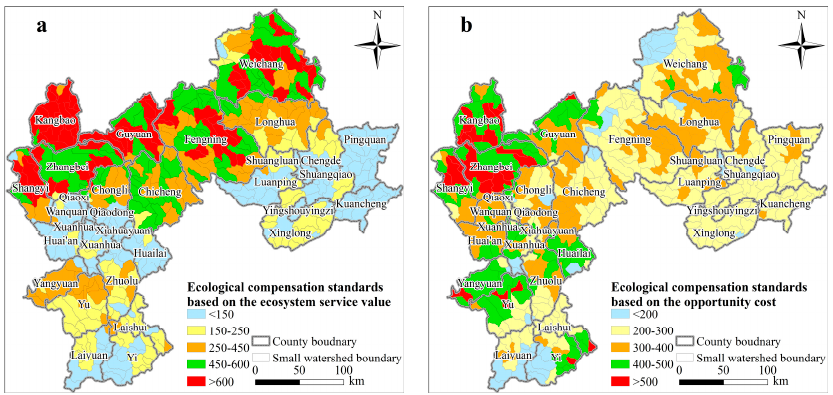
Figure 3. Ecological compensation standards based on the ( a ) ecosystem service value and ( b ) opportunity cost in the study area.